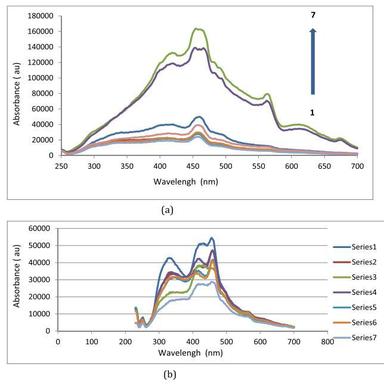
(a): Fluorescence spectra of DMPI (50 µM) with different HP-β-CyD concentration (µM): 1) 20 µM 2) 30 µM, 3) 40 µM 4) 50 µM, 5) 60 µM, 6) 70 µM, 7) 80 µM. 6 (b): DMPI (50 µM) with different β-CyD concentration (µM): 7) 20 µM, 6) 30 µM, 5) 40 µM, 4) 50 µM, 3) 60 µM, 2) 70 µM, 1) 80 µM, obtained from the set of solution.